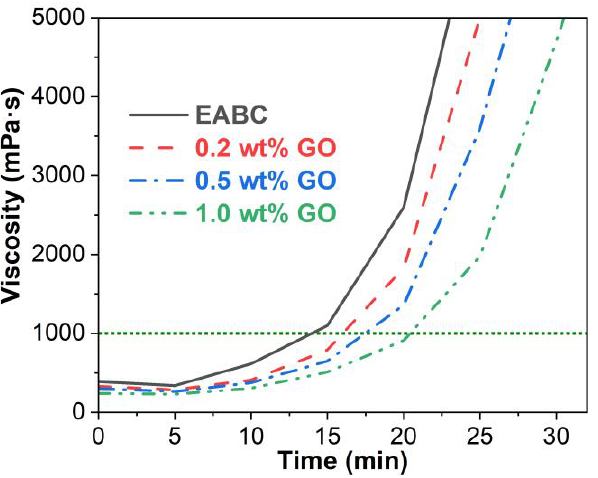
Figure 6. Viscosity – time curves of the unmodified and GO-modified EABCs at 120 °C. Figure 6. Viscosity–time curves of the unmodified and GO-modified EABCs at 120 ◦